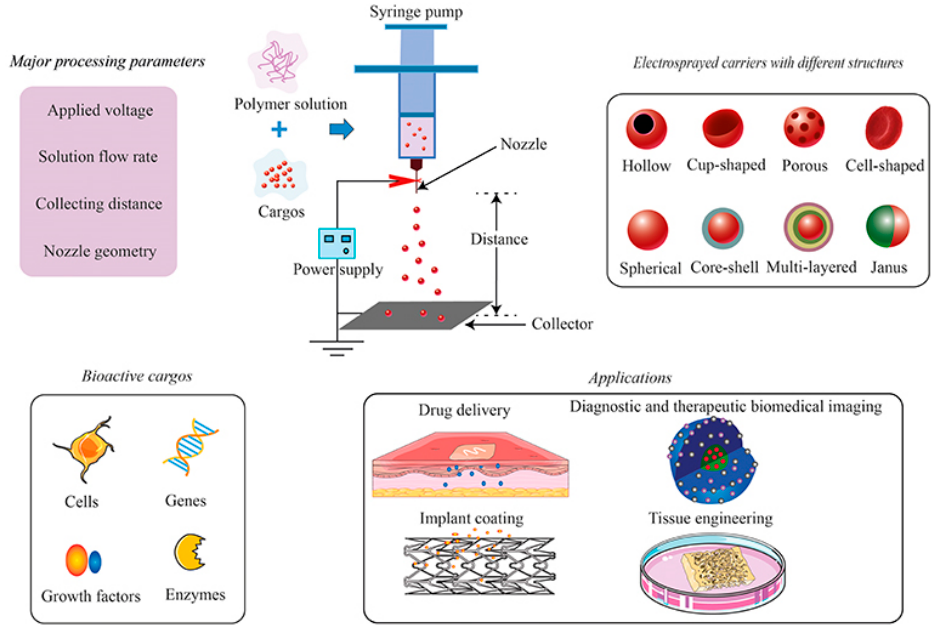
Figure 7. Graphical abstract of electrospraying and its applications; reproduced from [94].